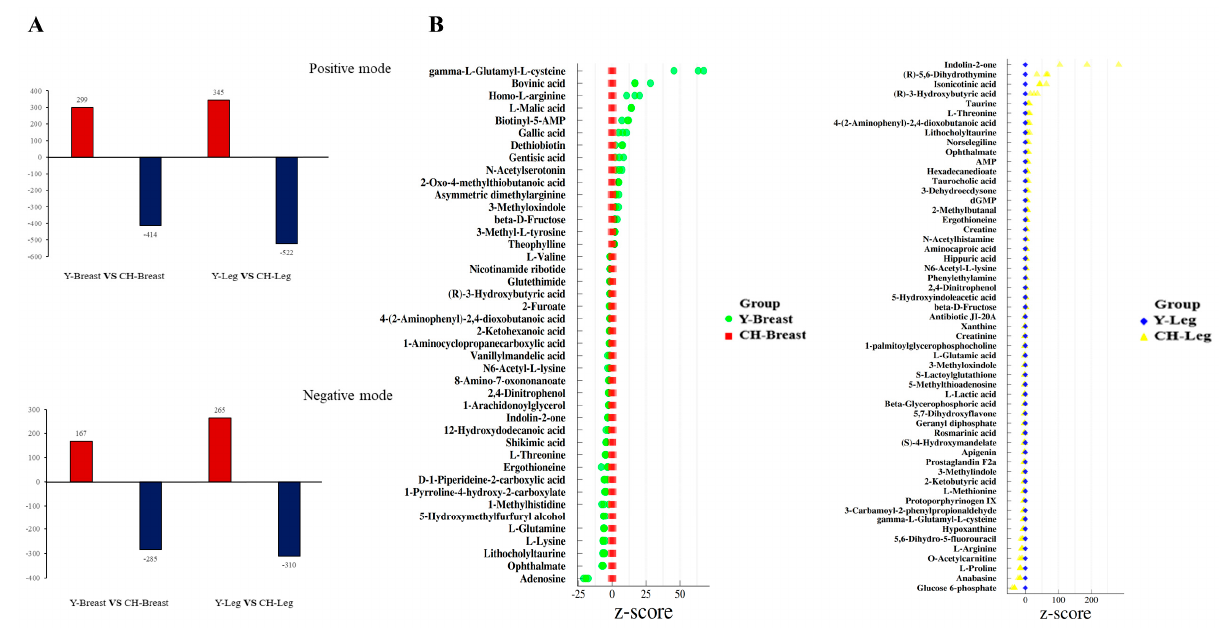
Figure 4. Screening and identification of differential metabolites. ( A ) Statistical results of different metabolites of breast muscle and leg muscle in positive and negative ion mode. ( B ) Z − score of dif- ferent metabolites.